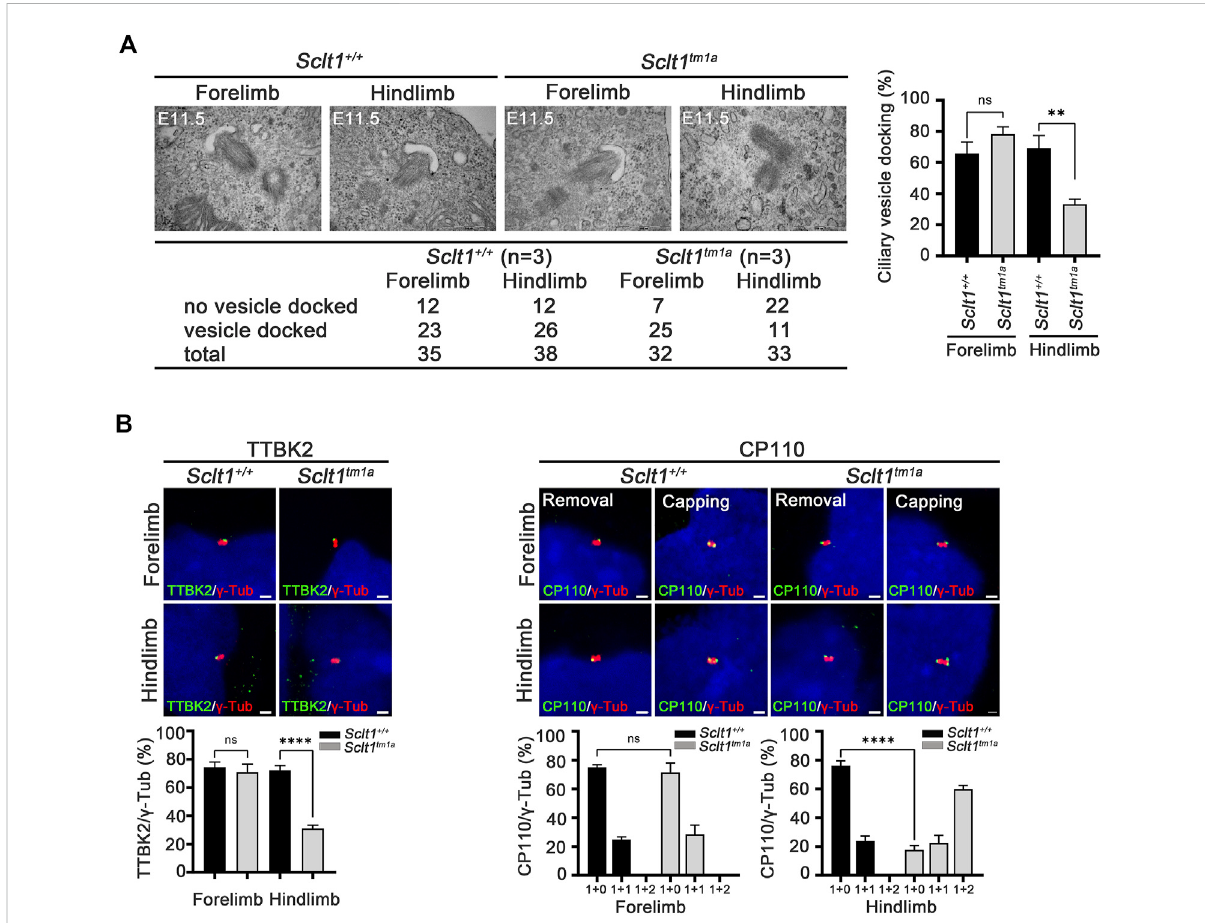
FIGURE 3 Sclt1isrequiredforinitiationofciliogenesisbyanchoringciliaryvesiclethroughDAPsandsubsequenttau-tubulinkinase-2(TTBK2)recruitment (A) TransmissionelectronmicroscopyanalysisofdevelopinglimbbudsatE11.5wascarriedouttoidentifytheearlystageofciliogenesis,ciliaryvesicle dockingtothemothercentriole.LossofSclt1resultedinreducedciliaryvesicleformationinthedistalendofthecentriole.Quantitativeanalysis(right panel) was conducted to compare the extent of ciliary vesicle docking in limb buds from Sclt1 mutant and wildtype control embryos. Error bars represent SEM ( n = 3 independent samples; ** p < 0.01, Student ′ s t tests) (B) To examine the effects of Sclt1 on TTBK2 and CP110 localization in cultured limb mesenchymal cells, immuno fl uorescent images were taken from cells co-stained with anti-TTBK2 (green) or with CP110 antibodies (green), and with γ -Tub antibody (red). Representative images were shown in the top panel and quantitative results are presented in the bottom panel. Error bars represent SEM values and asterisks denote statistical signi fi cance according to Student ′ s t tests (**** p <